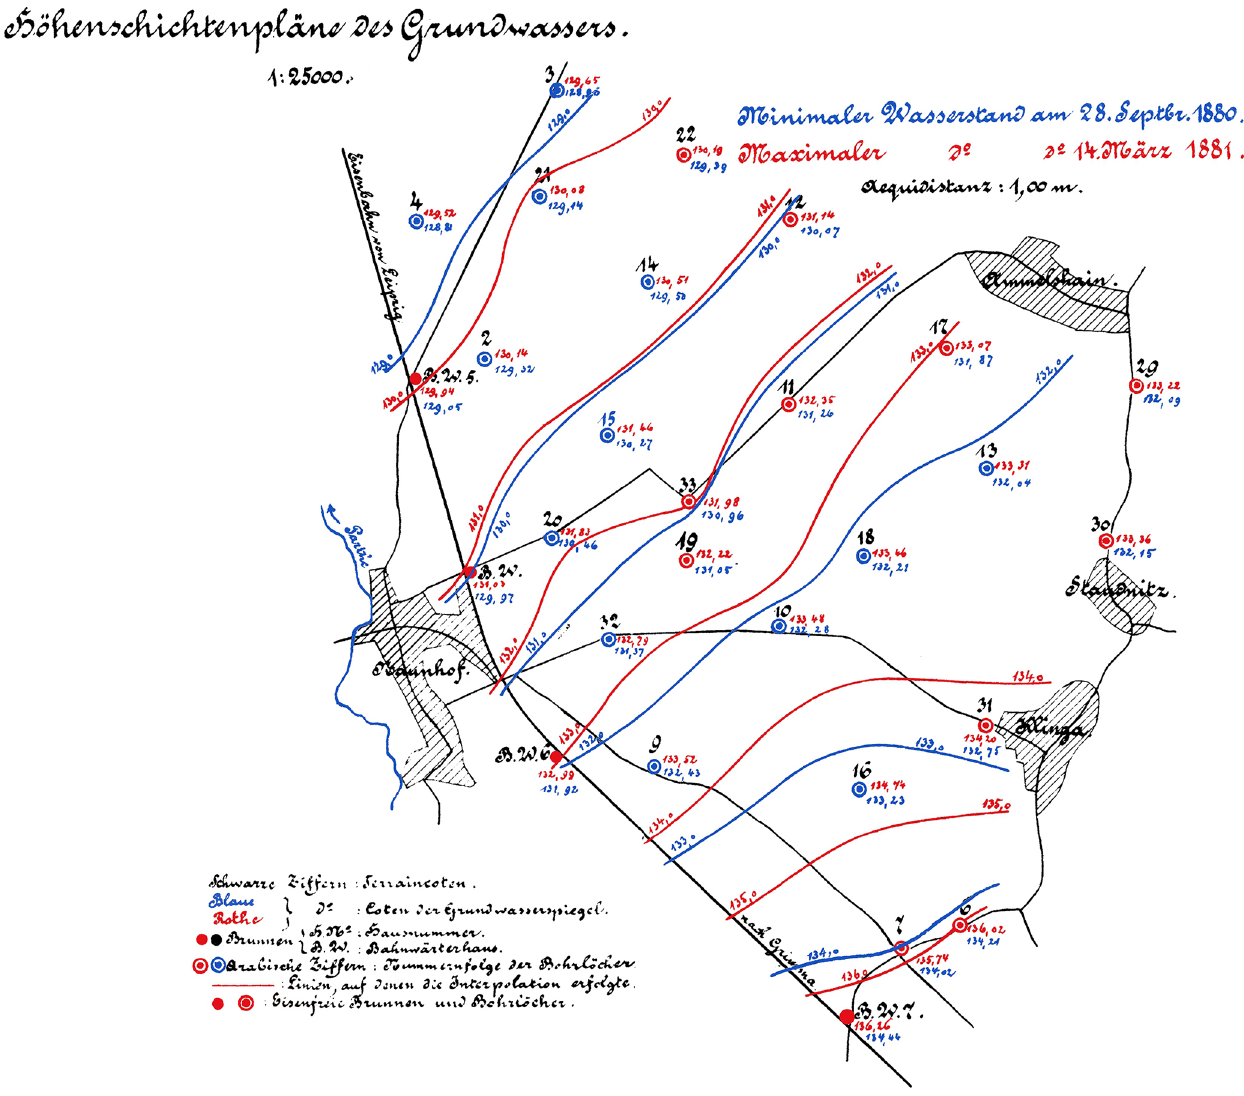
Figure 6. Isopotential map from the Leipzig–Naunhof study (Thiem, 1881e). The blue isopotentials are from 1880, and the red ones are for 1881. Black dots and numbers show the observations wells. The straight black line to the west is a train track, and the shaded areas are